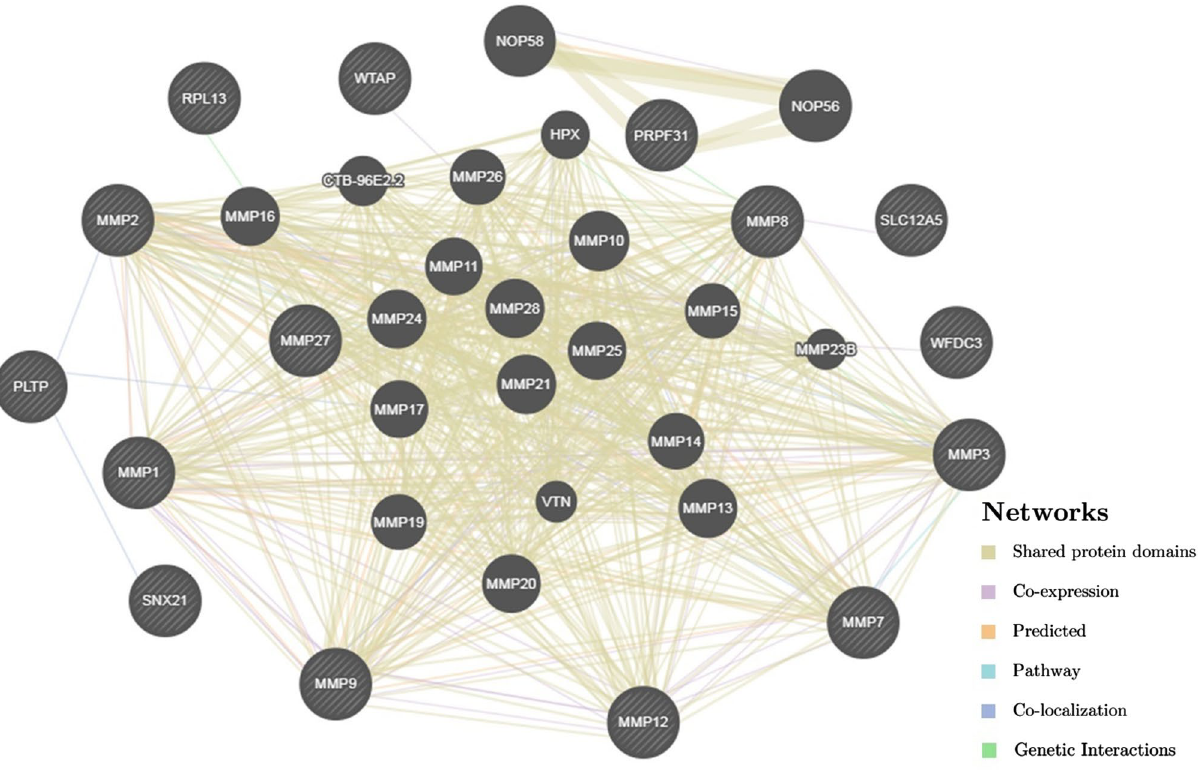
Figure 2. The interaction network of the candidate genes for EH obtained using the GeneMANIA online service, http://www.genem ania.org/ (the genes associated with EH according to the present study are cross-